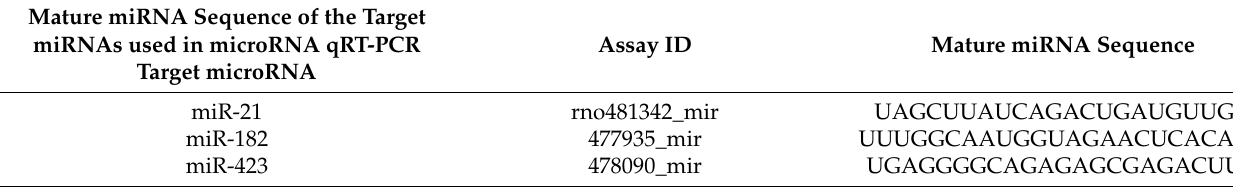
Table 2. Target microRNA sequences.